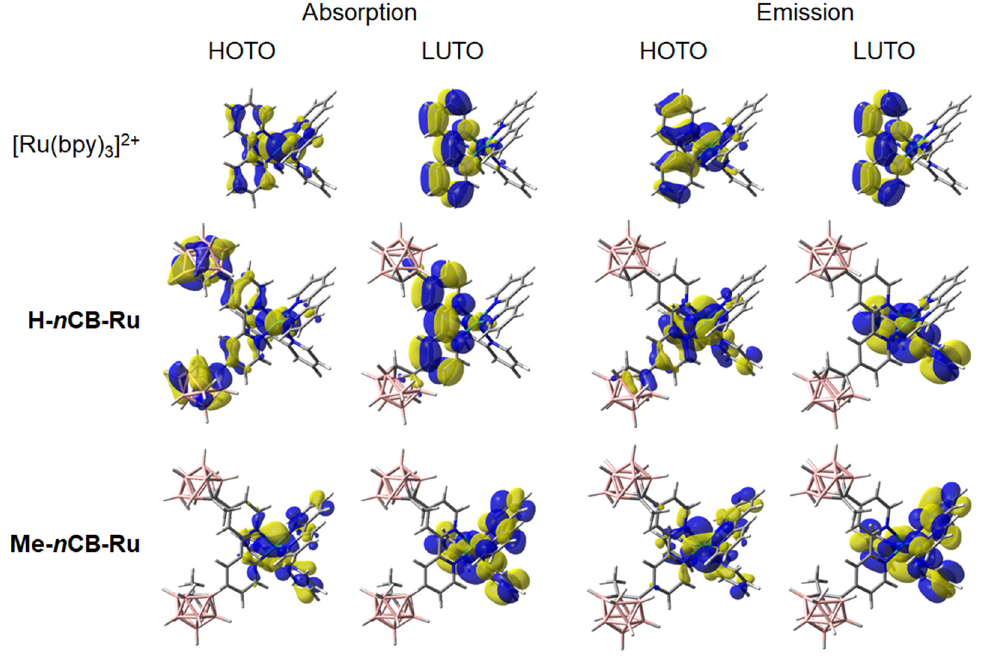
Figure 4. Natural transition orbitals calculated from the transitions of absorption and emission with the ruthenium complexes.